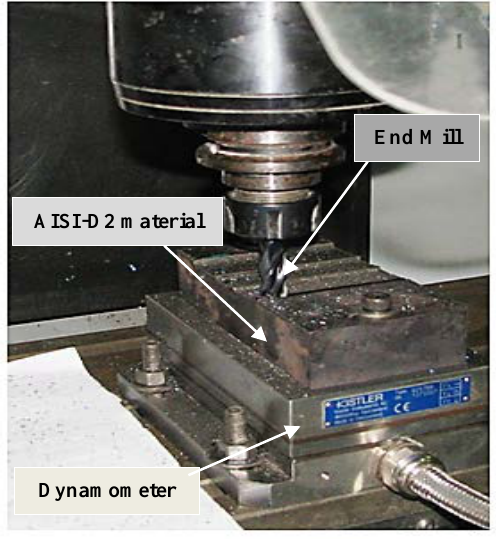
Fig. 1. Experimental set-up : End mill, AISI-D2 hardened steel, and 3-component force